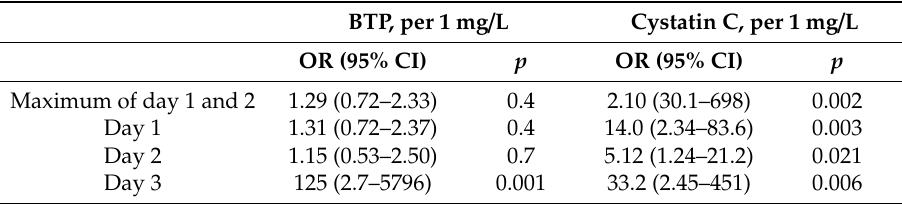
Table 3. Odds ratios for the diagnosis of AKI according to KDIGO obtained in logistic regression adjusted for prediagnosed kidney comorbidity.